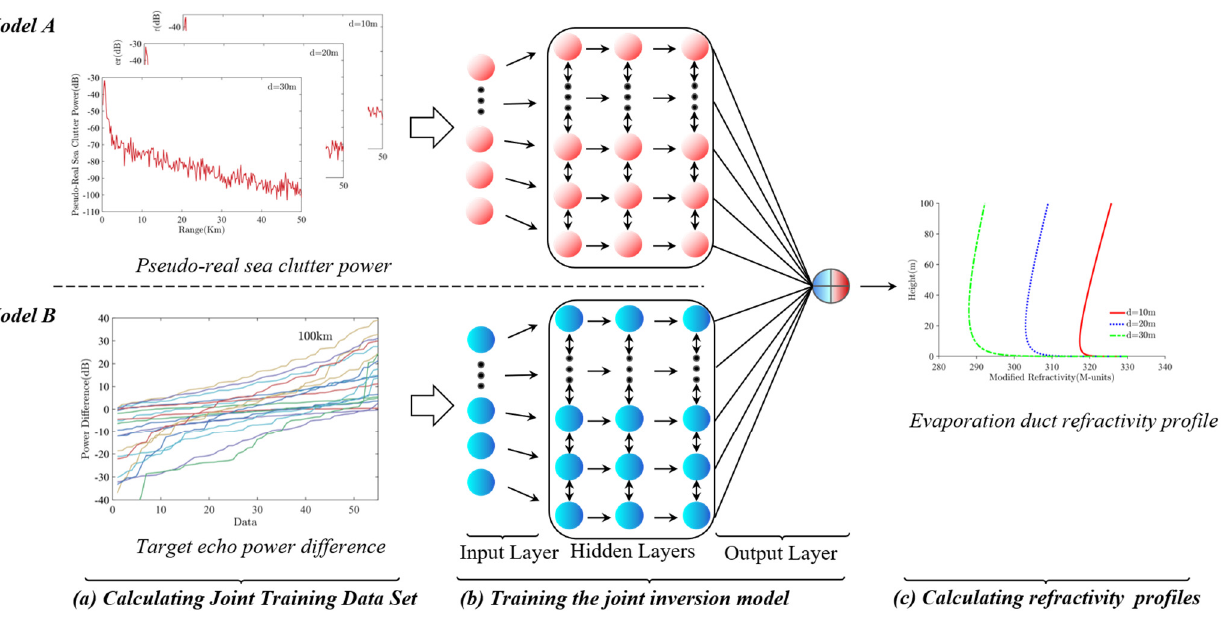
Figure 10. DNN − based joint inversion model framework.